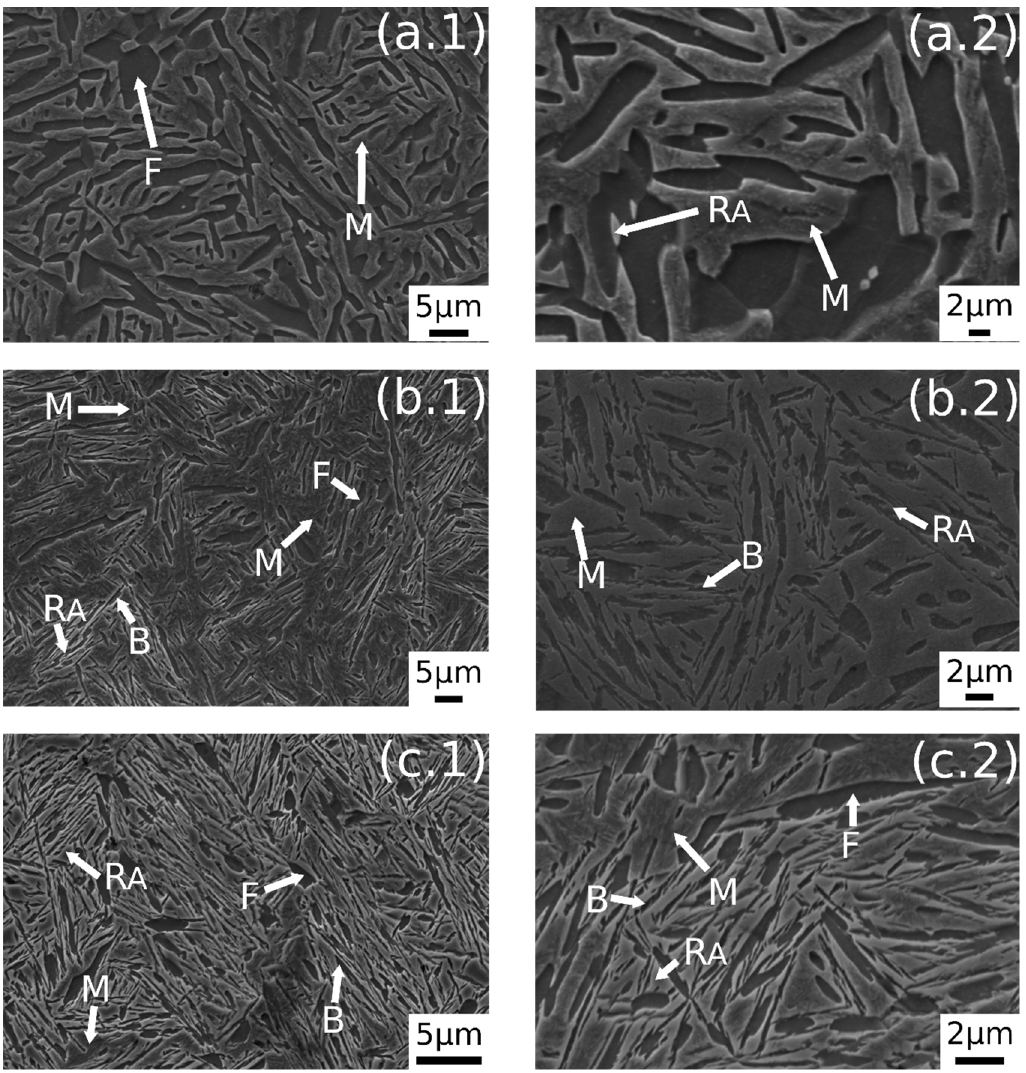
Figure 3. SE-SEM images of the surfaces of the samples: ( a.1 , a.2 ) 780 °C + 350 °C, ( b.1 , b.2 ) 830 °C + 350 °C, ( c.1 , c.2 ) 850 °C + 350 °C. (M martensite, F ferrite, R A retained austenite, B carbide free bainite).